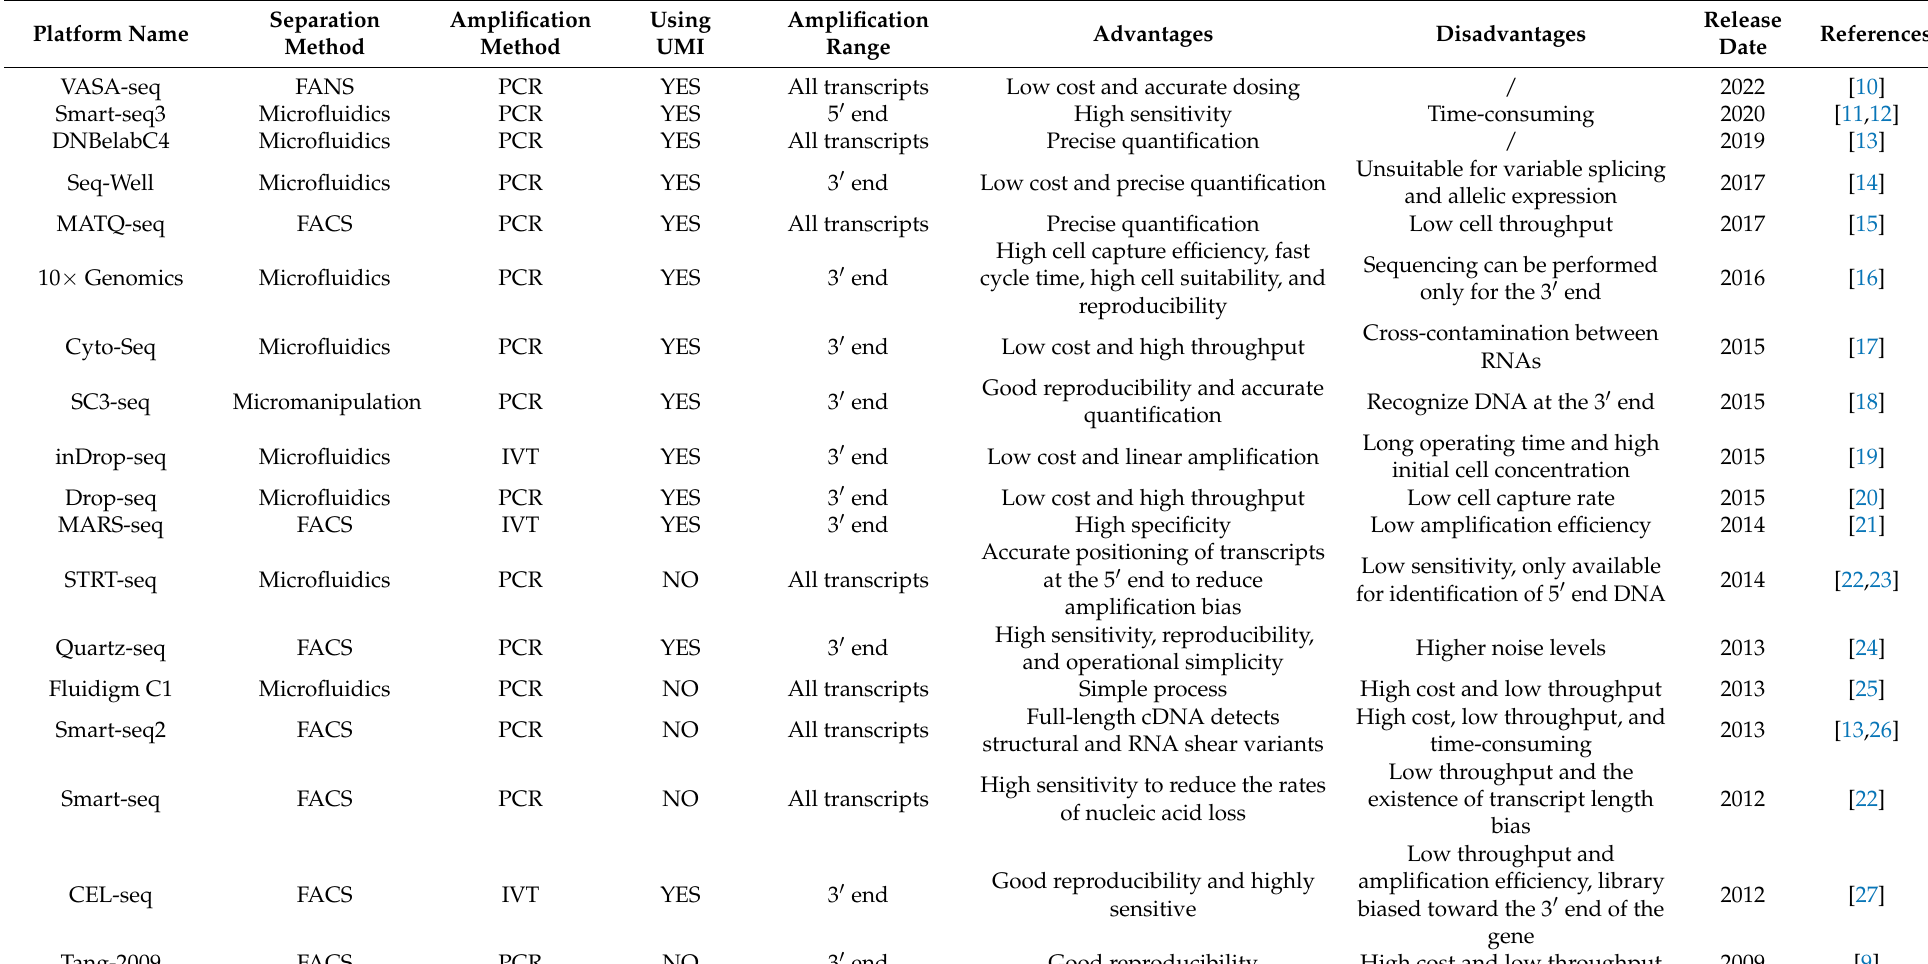
Table 1. Comparison of different ScRNA-Seq technology